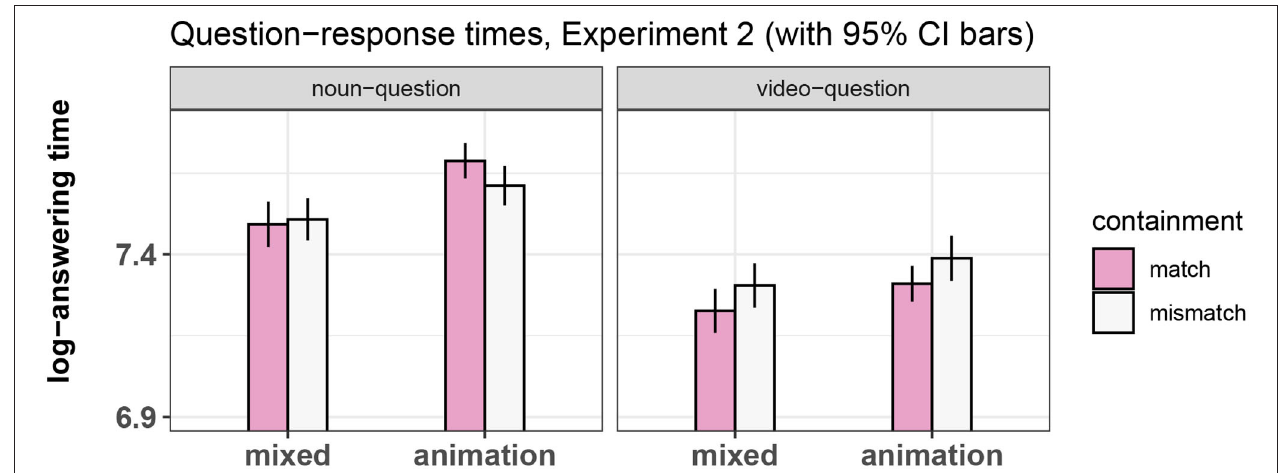
FIGURE 10 | Summary of results for the question response time, Experiment